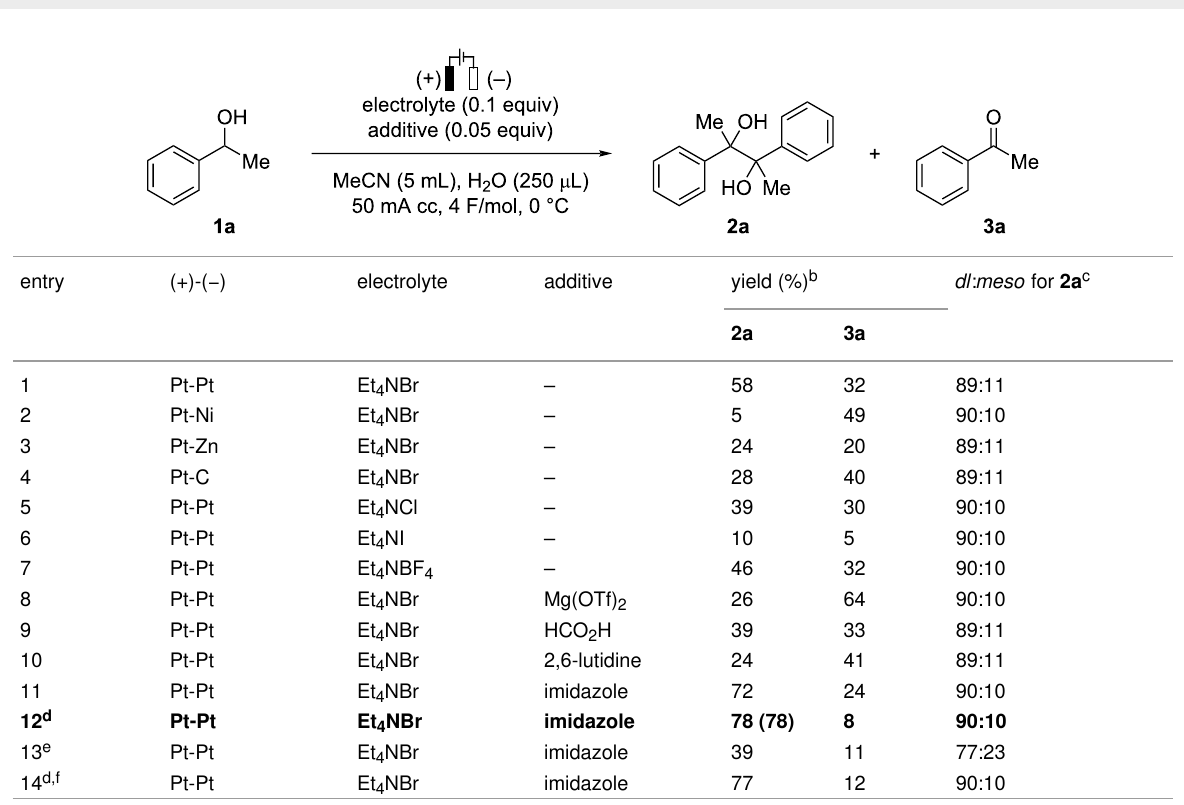
Table 1: Optimization of reaction conditions.